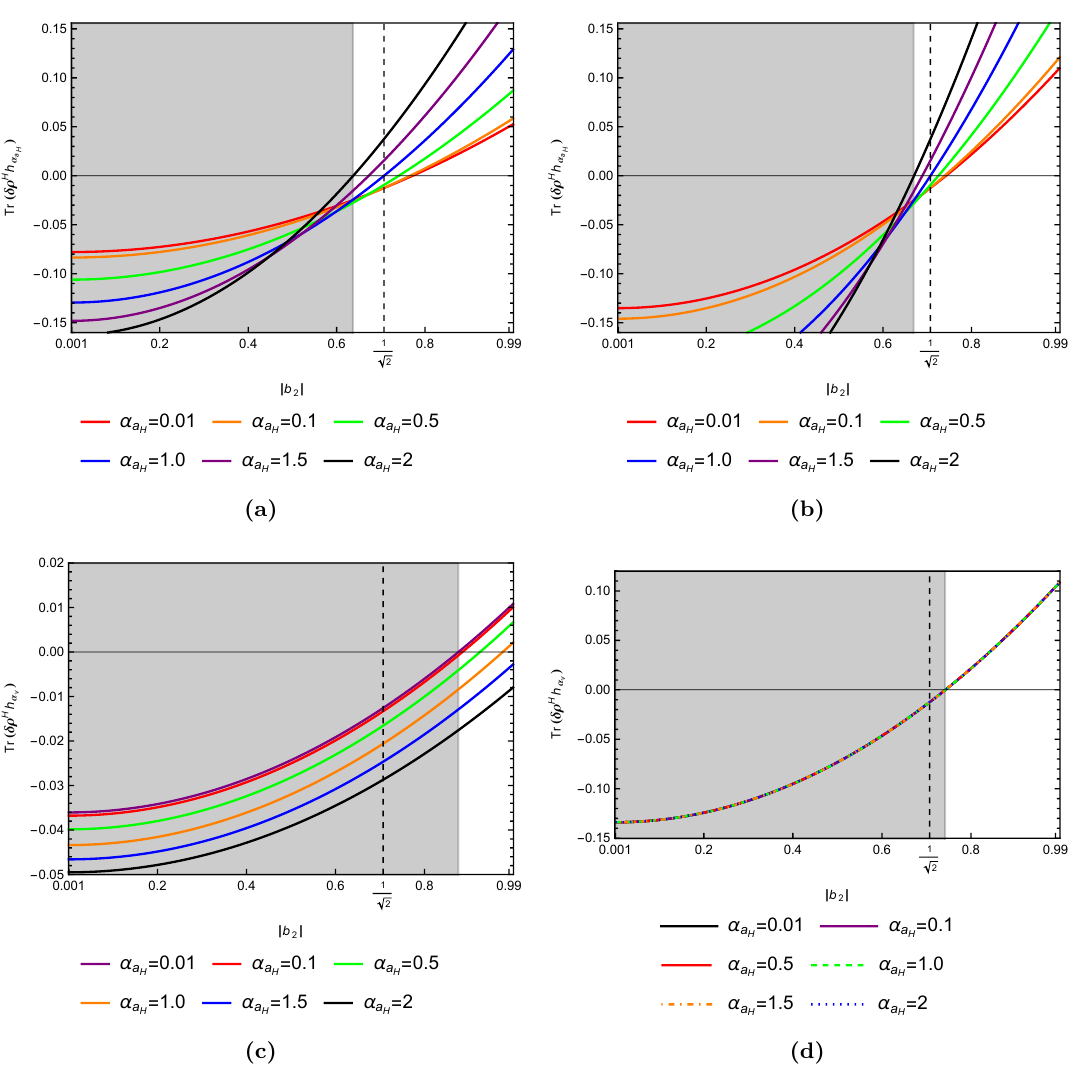
Figure 5. Initially non-maximally entangled state for anti-parallel motion (with fixed W = 0 . 2 ): plots (a) and (b) are showing traces corresponding to heat absorbed by the system, Tr( δρ H h ) α aH with respect to | b for different α for A = 0 . 5 and 5 . 0 , respectively. Plots (c) and (d) are showing 2 | a H traces corresponding to work done by the system, Tr( δρ H h ) with respect to | b for different α α v 2 | a H for A = 0 . 5 and 5 . 0 , respectively. The grey region in the plots roughly represent the regime with negative traces for all given α a H